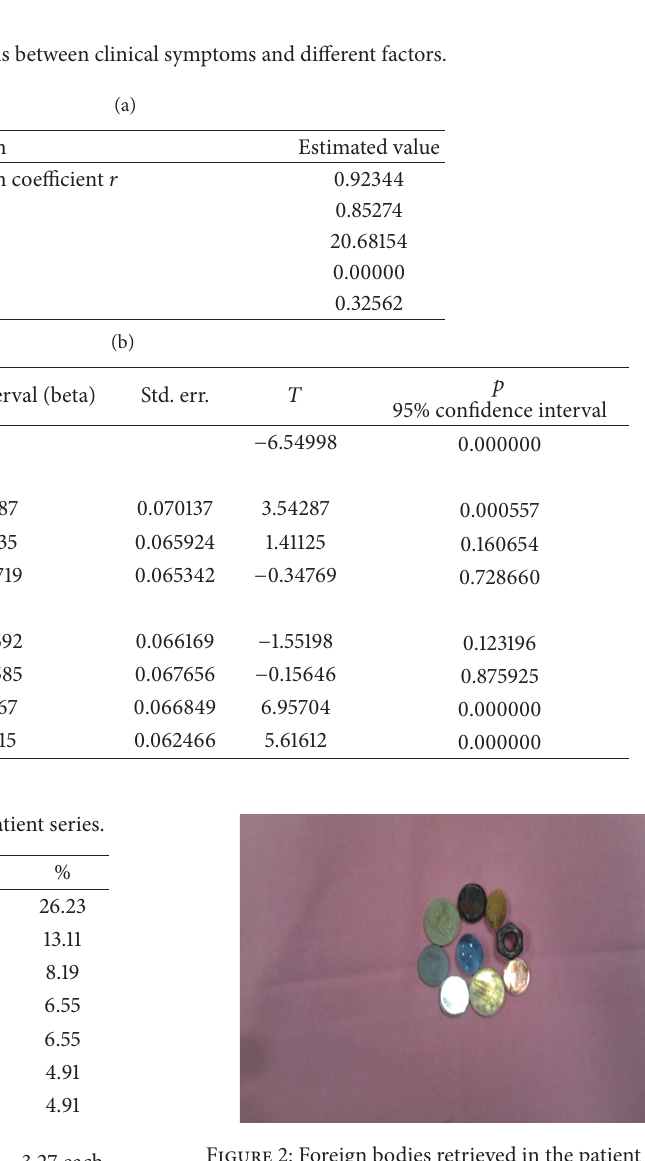
Figure 2: Foreign bodies retrieved in the patient